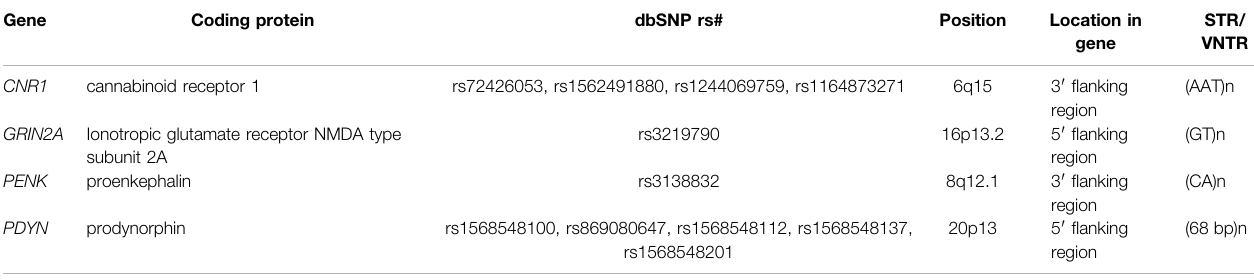
TABLE 2 | Short tandem repeats analyzed in the present study.